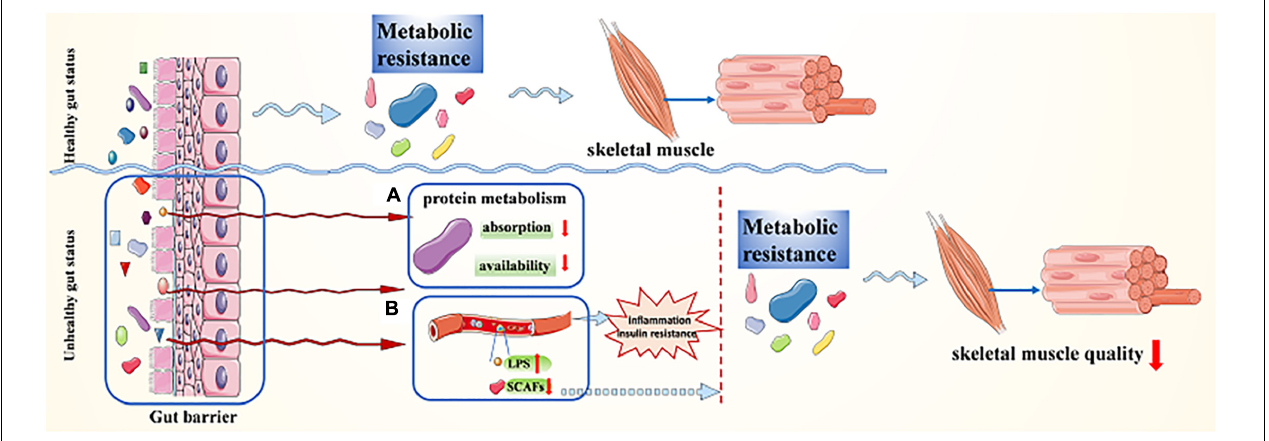
FIGURE 2 | Transmutation of gut status maintains sarcopenia via metabolic resistance. (A) The changes in gut microbiome composition and/or diversity result in changes in protein metabolism; (B) gut microbial dysbiosis leads to gut barrier dysfunction, which causes the concentration of LPS in the blood to rise and/or SCFAs to